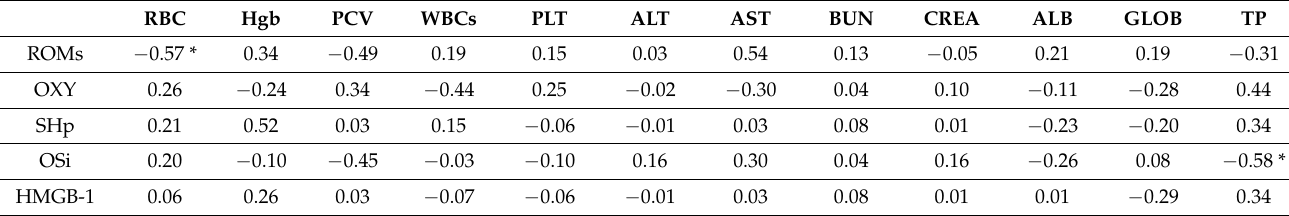
Table 5. Correlation between HMGB-1, oxidative stress and hematochemical analytes in LEISH Group dogs (Spearman rank order) (* p <